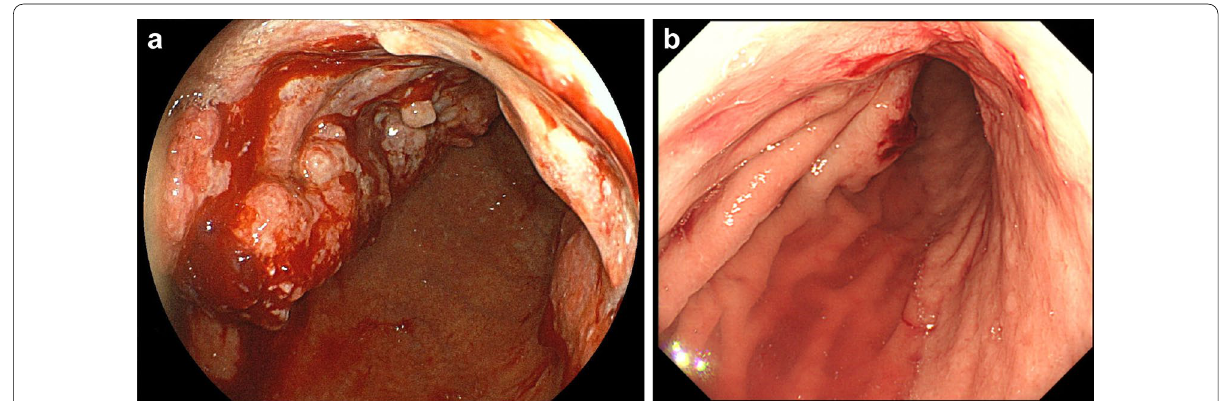
Fig. 1 Esophagogastroduodenoscopy image. a Before chemotherapy. A type 2 tumor that extends from the upper to middle third of the stomach is seen. b Size of the primary tumor has remarkably reduced after six courses of ramucirumab plus